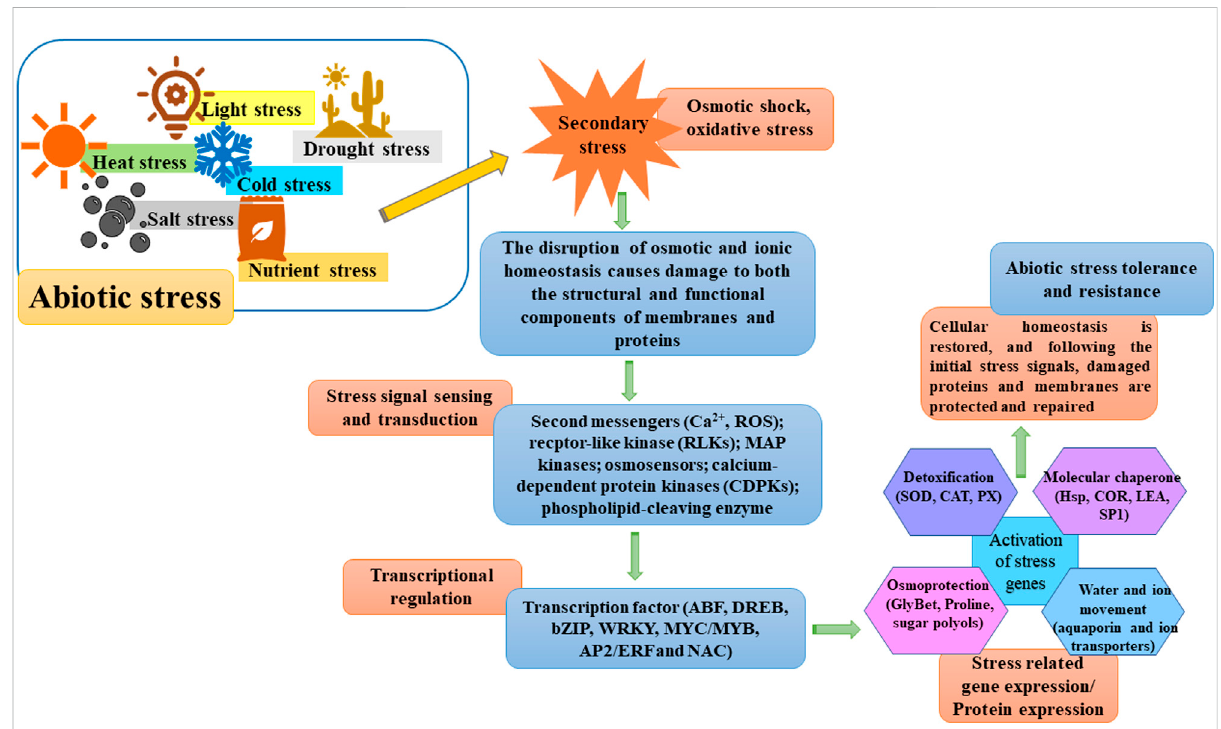
FIGURE 1 Asimpli fi edschematicrepresentation ofmechanism throughwhich plantresponsesto diverseabiotic stress. Thegeneralsignalingpathways in plants that are activated in response to abiotic stress, beginning with signal perception and leading to the stress responses. Cold, drought, light, nutrient and salinity frequently induce cellular damage and secondary osmotic and oxidative stress. Following upstream signaling processes and transcriptional controls activate stress-responsive mechanisms in order to restore cellular homeostasis and protect and repair damaged proteins and membranes after the initial stress signals (e.g., changes in temperature or osmotic and ionic effects or membrane fl uidity). ABF, ABA responsive element (ABRE) binding factor; AP2/ERF, Apetala2/Ethylene Responsive Factor; bZIP, basic leucine zipper transcription factor; CAT, catalase; CBF/DREB, C-repeat-binding factor/dehydration-responsive-binding protein; CDPK, calcium-dependent protein kinase; COR, cold- responsive protein; HK1, histidine kinase-1; Hsp, heat-shock protein; ICE1, inducer of CBF expression 1; LEA, late embryogenesis abundant; MAP, mitogen-activated protein; PLD, phospholipase D; PX, peroxidase; ROS, reactive oxygen species; SOD, superoxide dismutase; and SP1, stable protein